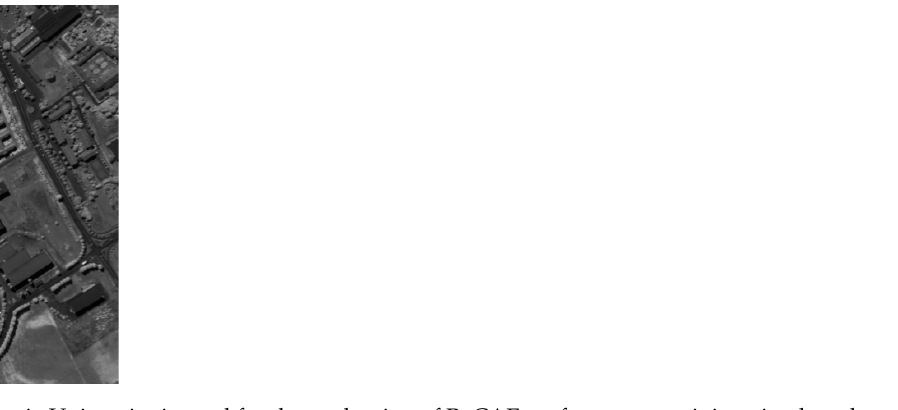
Figure 6. Pavia University is used for the evaluation of PyCAE performance, as it is trained on the Pavia center dataset.